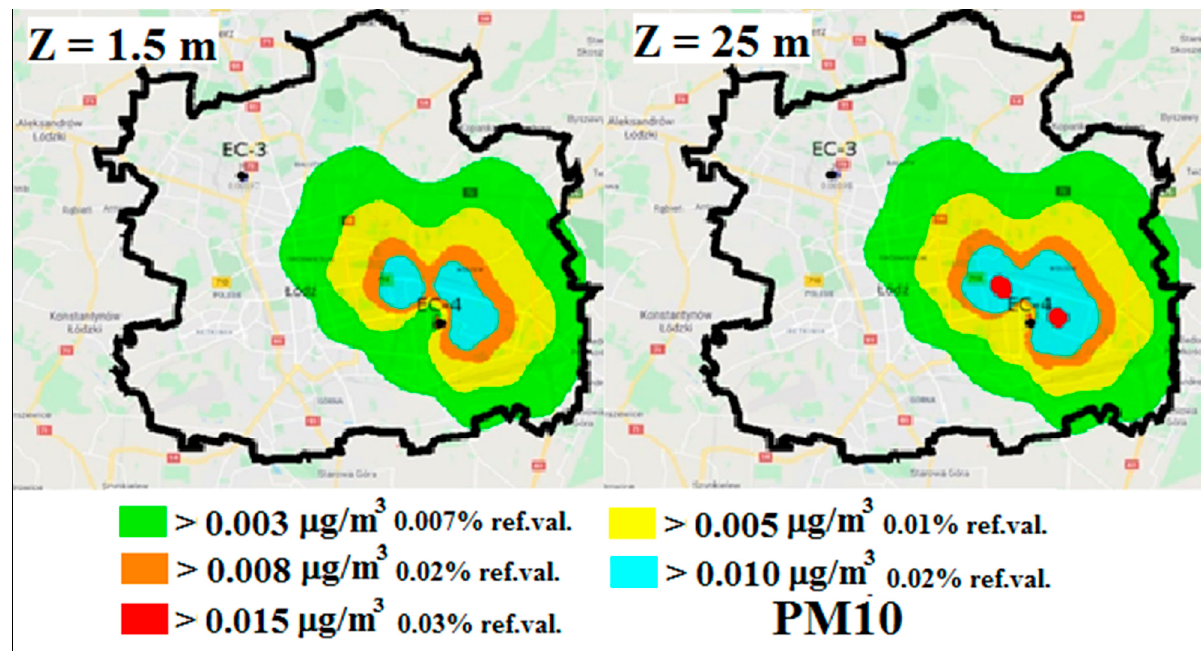
Figure 10. Distribution of annual average concentrations of PM 10 at the height of 1.5 m and 25 m surrounded by EC-4 in 2019 based on the results from OPA03.